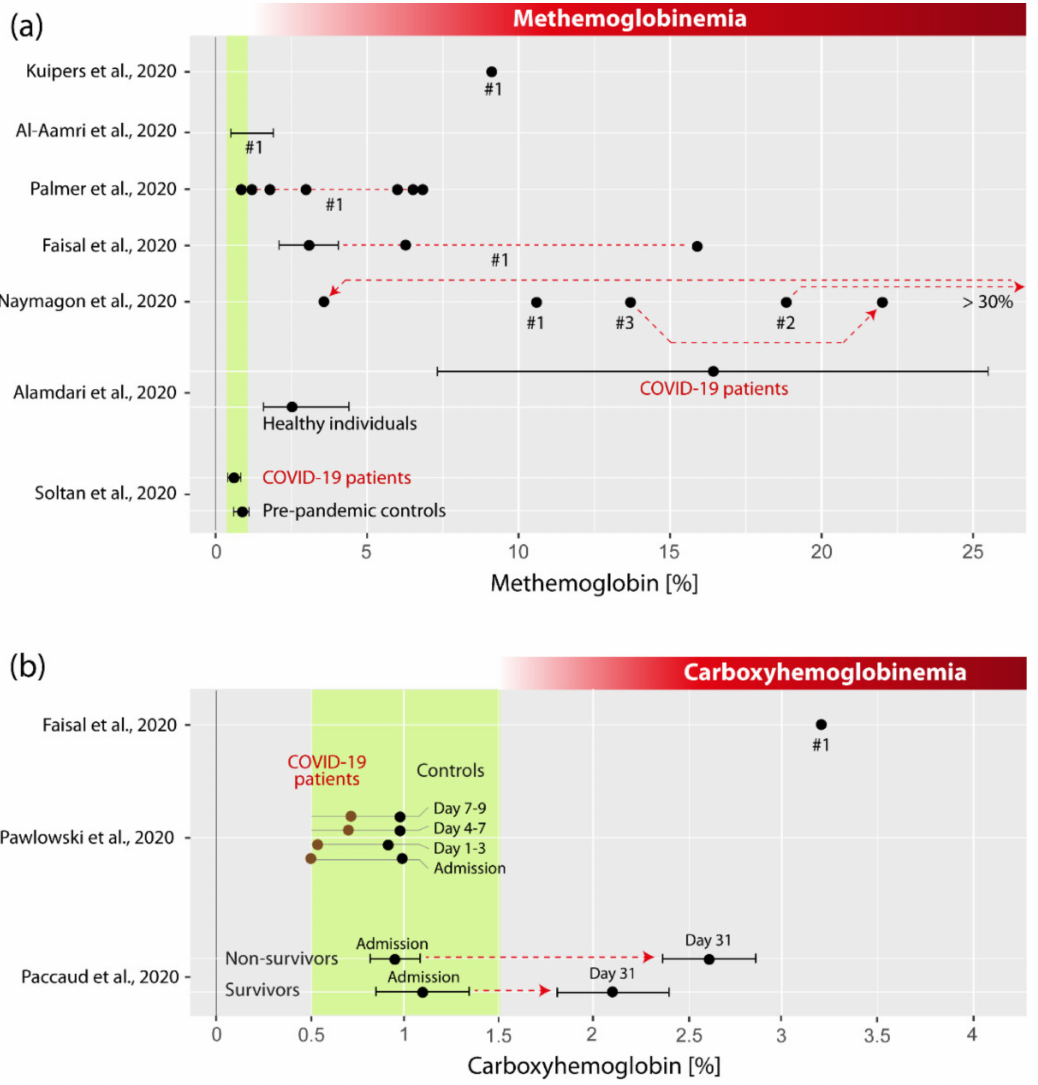
Figure 2. Visualization of ( a ) methemoglobin (MetHb) and ( b ) carboxyhemoglobin (COHb) values of COVID-19 patients reported in the literature. The green shaded areas refer to the reference ranges for healthy individuals in case of MetHb (0.67 ± 0.33% for healthy non-smokers [15]) and COHb (0.5–1.5% for healthy non-smokers [16]). Different subjects reported in the case reports are marked with “#”, and red lines with arrows indicate the development of subject-specific values during the course of the